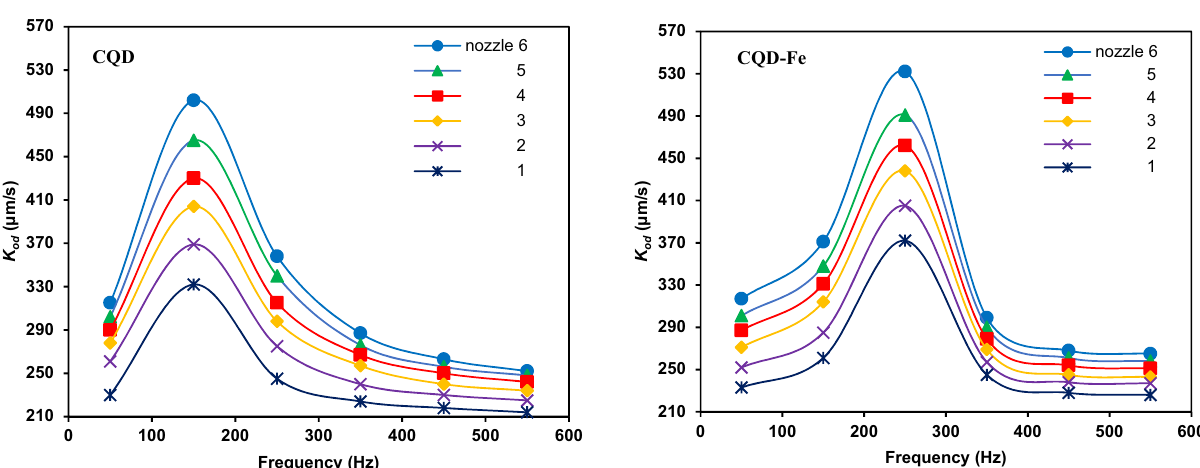
Figure 10. Mass transfer coefficient versus electric field frequency for different drops at typical electric field strength of 10 V/cm and concentrations of 0.0015 (CQD) and 0.002 wt%